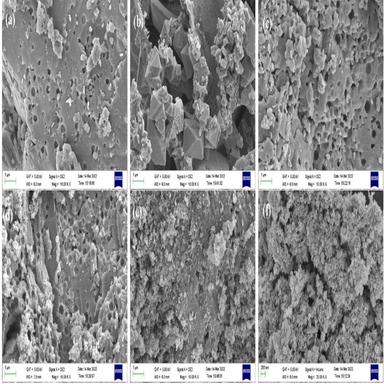
The SEM images of eggshell (a), CoFe composite (b), Co@Eggshell (c), Fe@Eggshell (d), and CoFe@Eggshell (e-f).